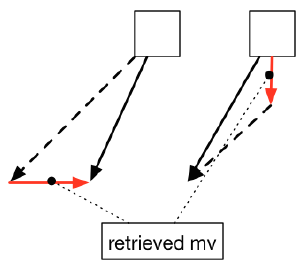
Figure 4. Motion vector decompostion on horizontal and vertical directions.